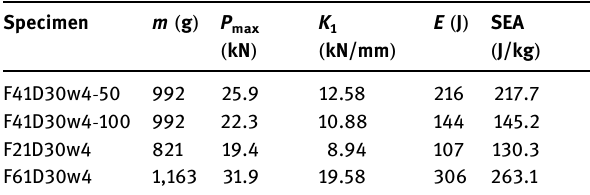
Table 8: Summary of simulated matrix and results